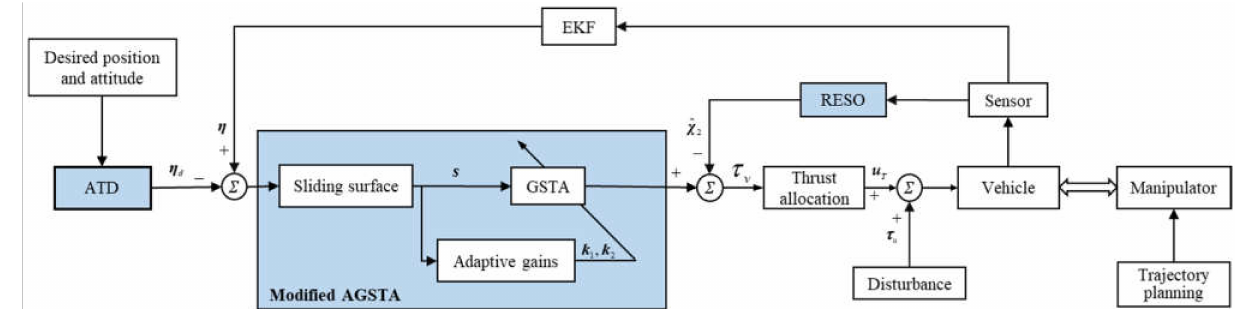
Figure 2. Diagram of the station-keeping control